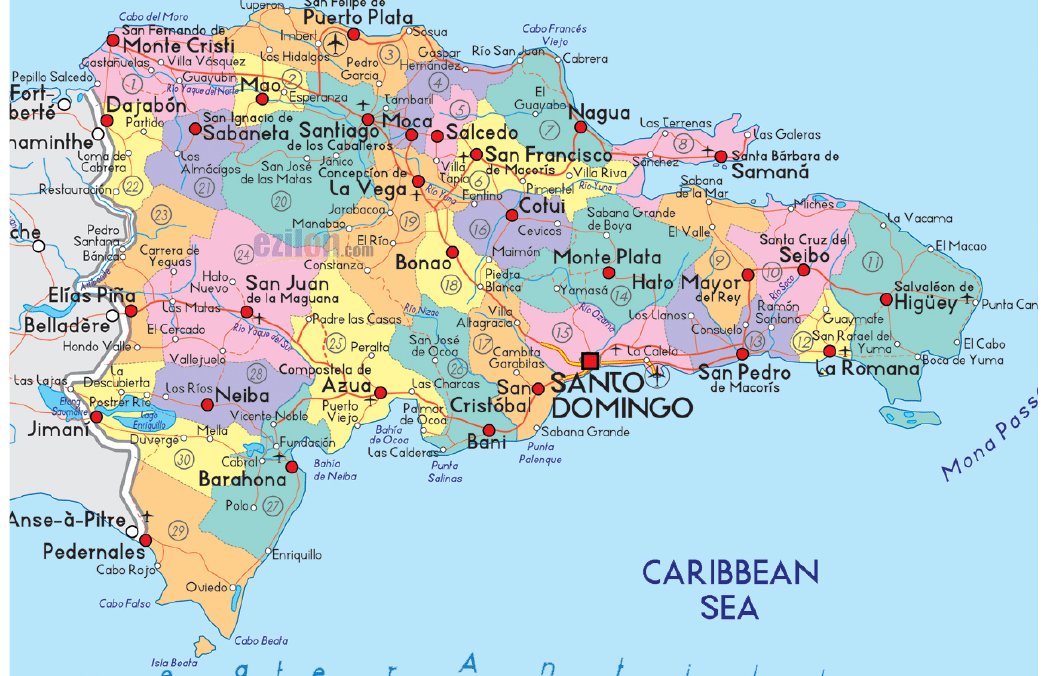
Figure 1. Map Library of the Dominican Republic: the Dominican Republic and Santo Domingo. Source: Vidiani (2011). Urban Planning, 2019, Volume 4, Issue 1, Pages